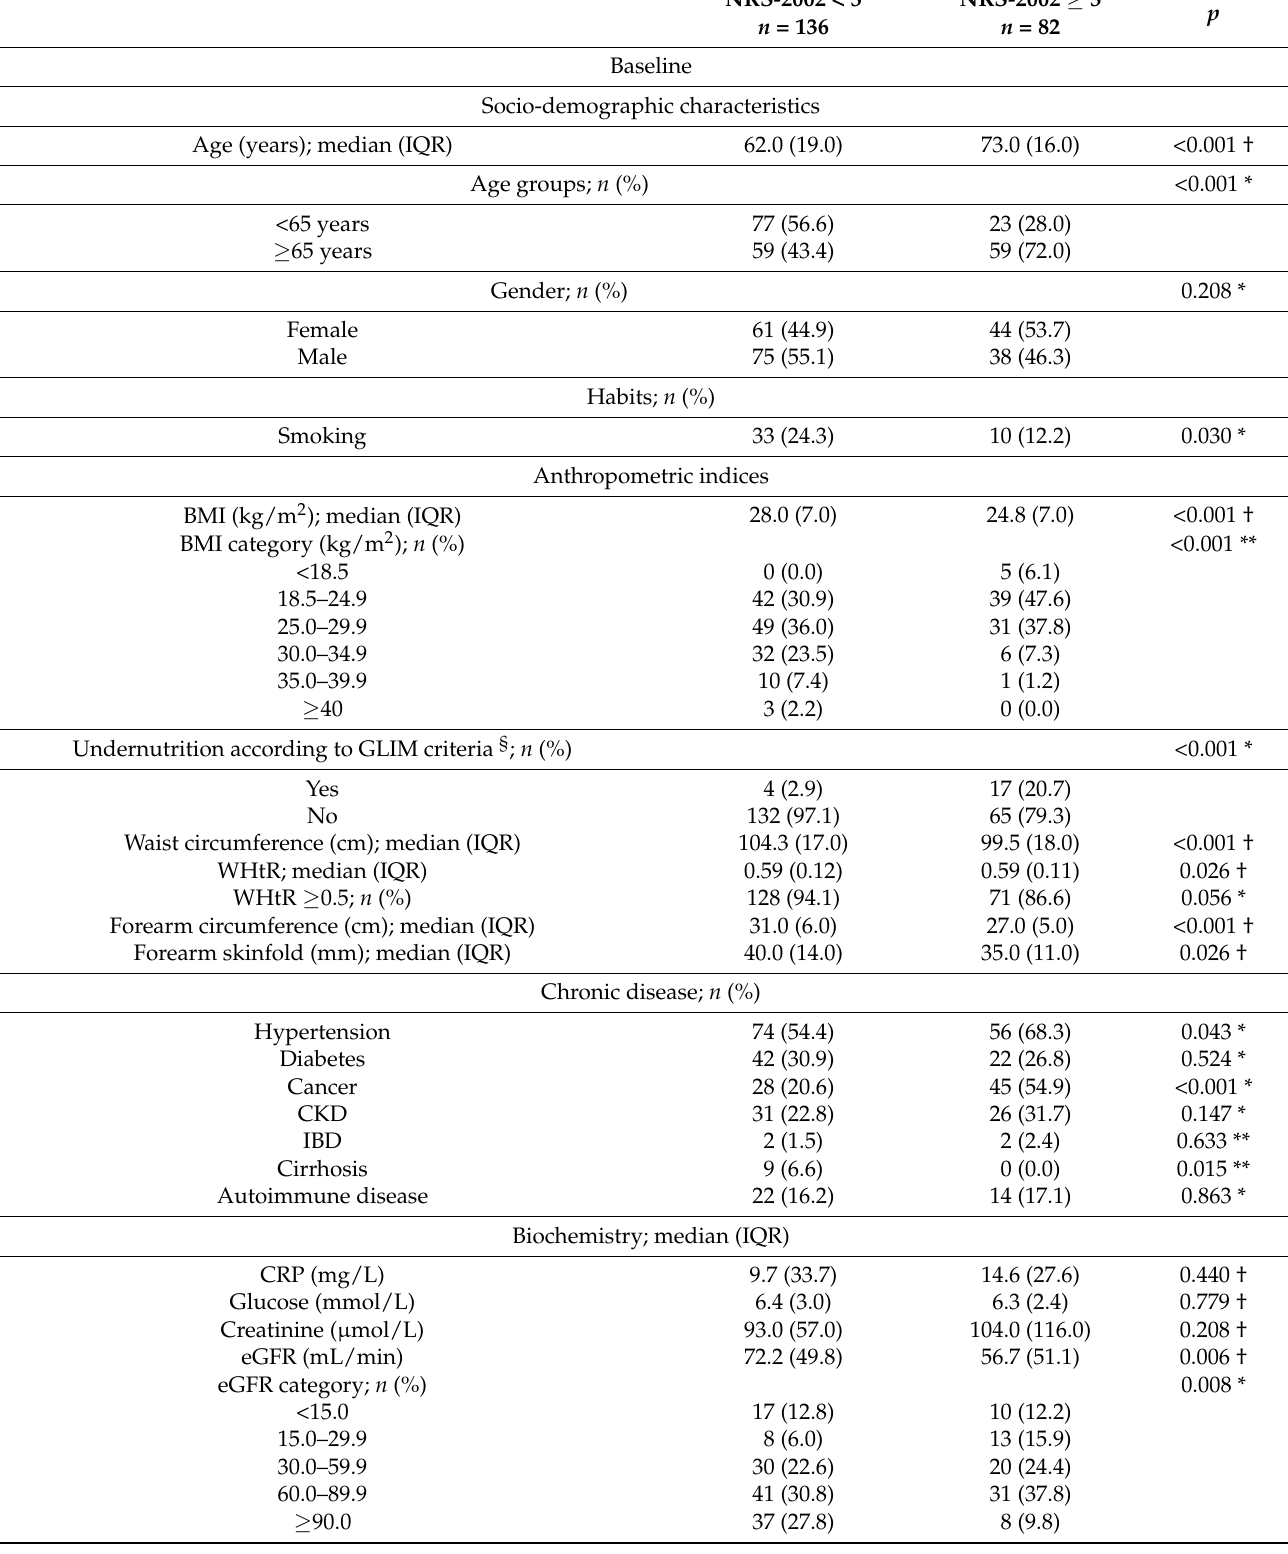
Table 2. Characteristics of subjects according to the NRS-2002 score in the followed-up